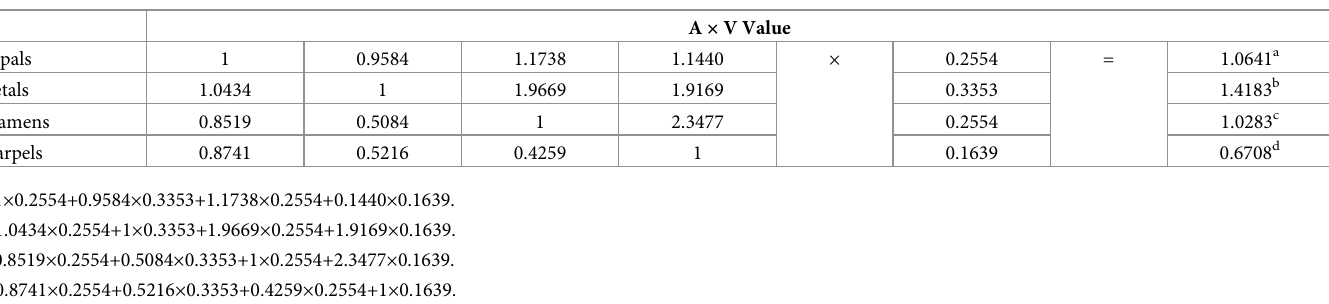
Table 6. A × V value.